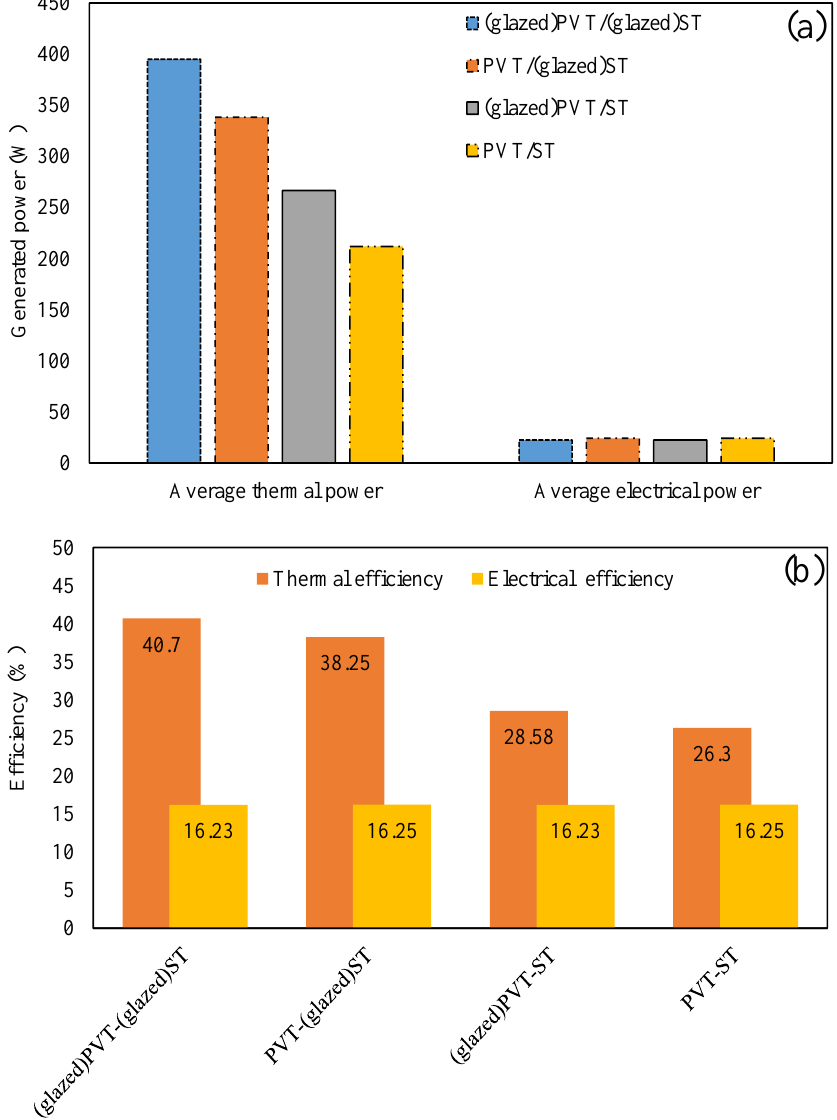
Fig. 12. Average thermal and electrical (a) power and (b) efficiencies for different PVT/ST with and without glass cover on various parts at the mass flow rate of 50 kg/h during a day in